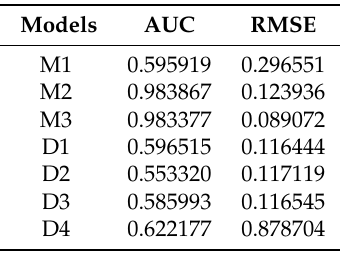
Table 6. Performance for the seven models using the top 10 features from model M2 on the test dataset.